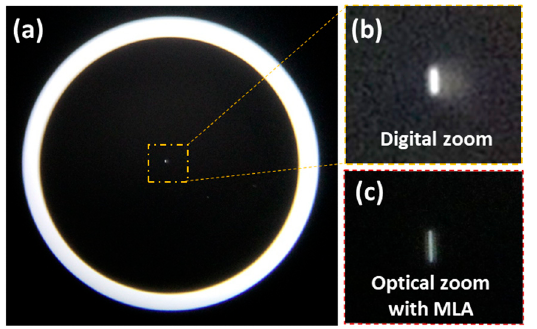
Figure 9. Comparison of magnification between the MCM and the MLA-assisted MCM. ( a ) Captured images of a scratch target through the MCM. ( b ) Digitally magnified image of scratch target. ( c ) Captured image of scratch target through and the MLA-assisted MCM.